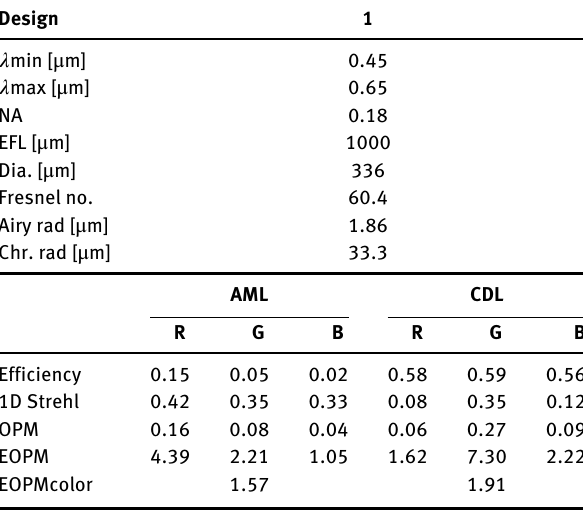
Table 3: Comparison of achromatic metalens (AML) based